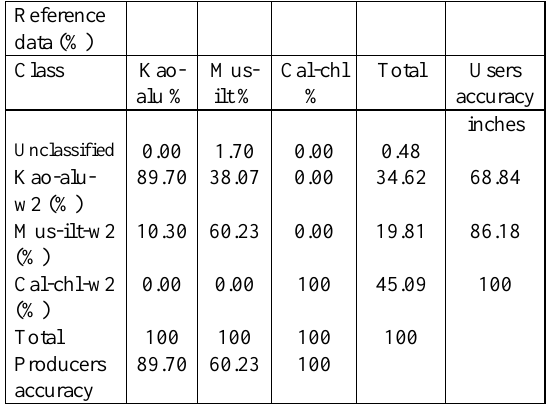
Table 2. Error matrix for SAM at 0.10 angle (image spectra) Overall Accuracy = 85.9%; Kappa Coefficient =